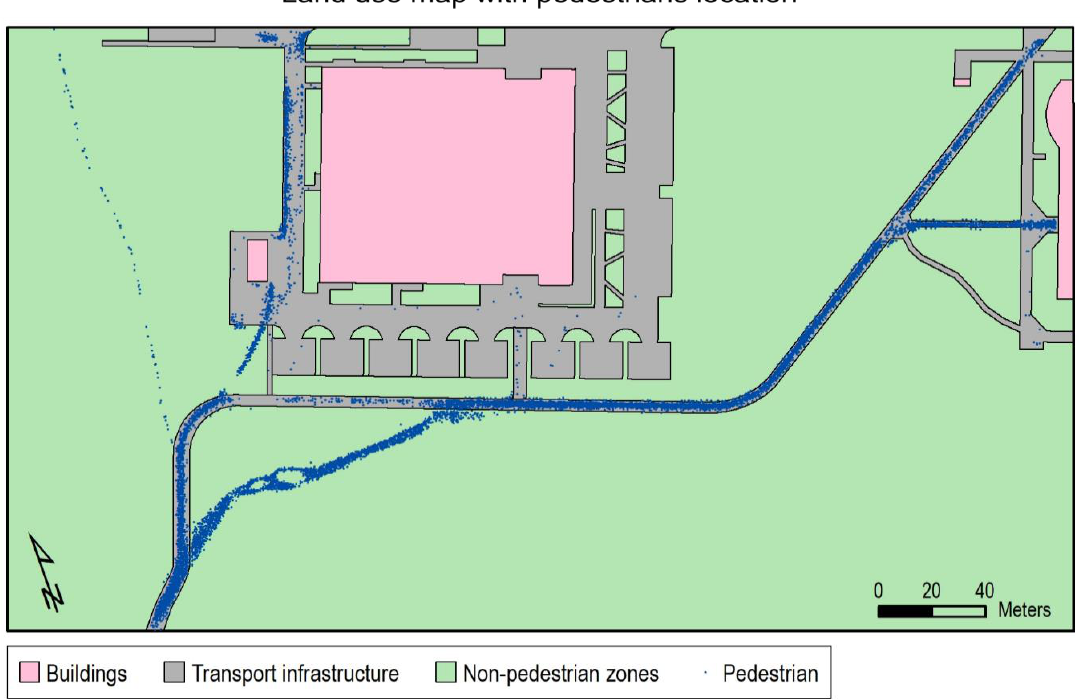
Figure 5. The map of land use with the location of pedestrians in the research area: the chorochromatic method (qualitative data) and the dot method (quantitative data).